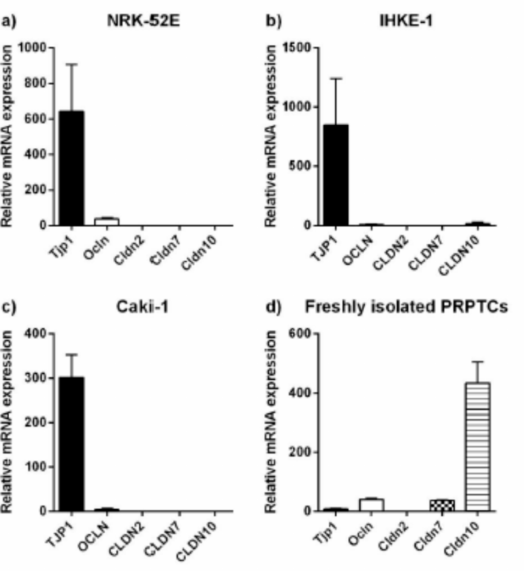
Figure 5. Relative mRNA expression of tight junction proteins in the renal cell lines NRK-52E ( a ), IHKE-1 ( b ) and Caki-1 ( c ), and in freshly isolated PRPTCs ( d ). The mRNA expression of each gene was normalized to GAPDH/Gapdh expression. Each bar represents the mean ± SD ( n =